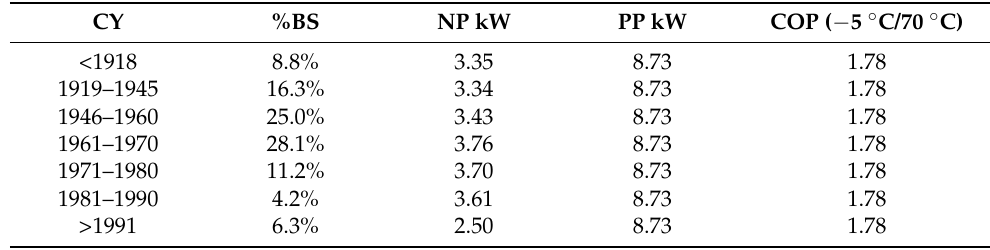
Table 3. Nominal power (NP), plate power (PP) and COP of the HP appropriate for the design value of the outdoor temperature of Milan ( − 5 ◦ C), per construction year CY (outlet water temperature 70 ◦ C) and portion of the building stock